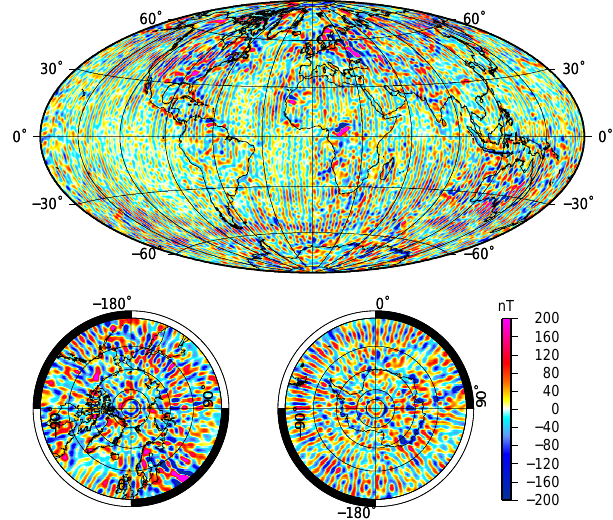
Fig. 5. Map of the vertical down component of the lithosphere mag- netic field model at r = 6371 . 2km radius derived after the step 1 of the processing chain. This corresponds to a smoothed model with- out co-estimation of the noise model. It is given here as a reference to be compared with Fig. 8. Along-track noise is particularly visible around Antarctica, and in the Indian, Atlantic and eastern Pacific